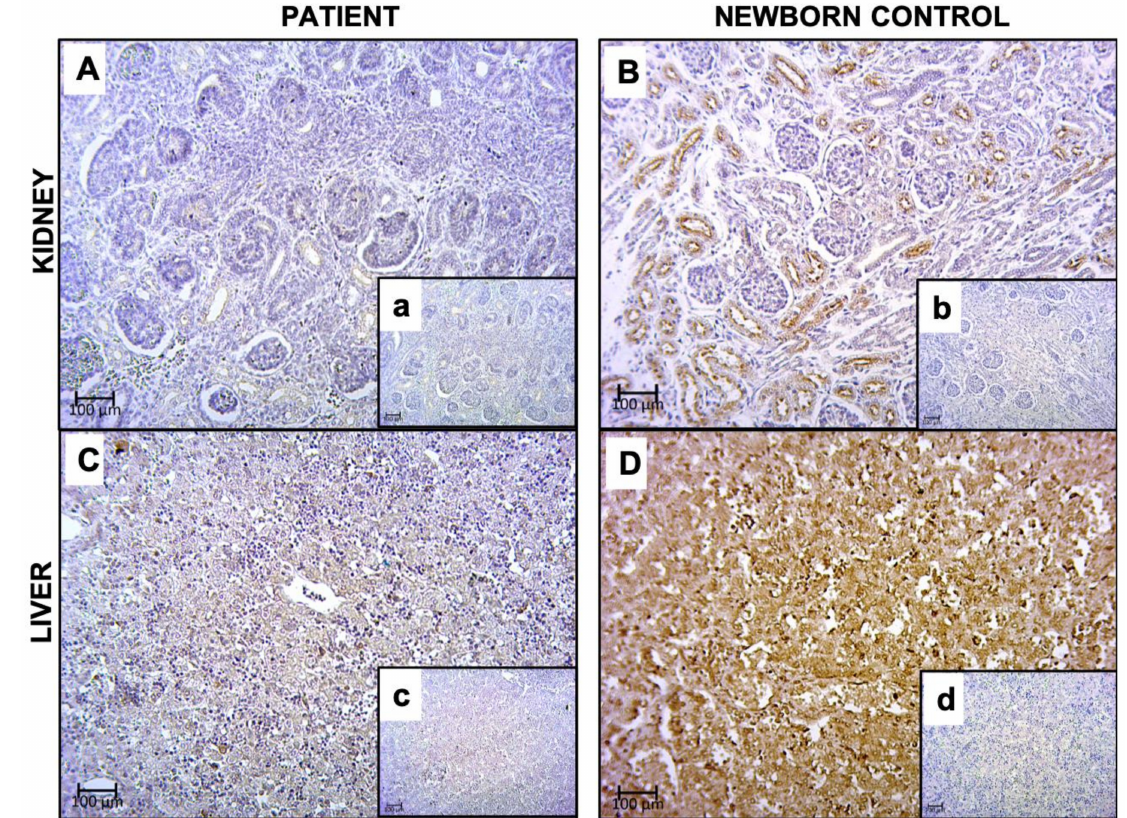
Figure 5. Representative images of FAM20C detection by immunohistochemistry (40 × ) in kidney and liver of patient with lethal Raine Syndrome (RS) (case 2) and necropsy tissue from a newborn without RS (gestational age 31 weeks). ( A ) Kidney from case 2, (a) negative control. ( B ) Kidney from newborn without RS (31GW), (b) negative control. ( C ) Liver from case 2, (c) negative control. ( D ) Liver from newborn without RS (31GW), (d) negative